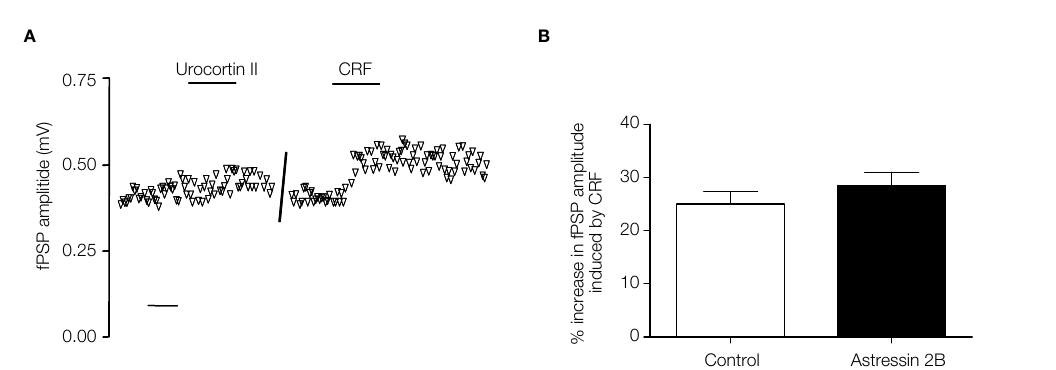
Figure 5 | (A) Example of the timecourse of fPSP amplitude before and after application of the CRF2 receptor agonist, urocortin II (0.1 μ M), and subsequently CRF (0.1 μ M) on the same slice. Each symbol represents the fPSP amplitude for a single response. Scale bar 10 min. (B) The increase in fPSP amplitude induced by CRF (0.1 μ M, n = 3 slices from 3 rats) is unaffected by the CRF2 receptor antagonist, astressin 2B (0.1 μ M, applied 20 min before 0.1 μ M CRF, n = 8 slices from 4 rats). Data shown are the mean ±